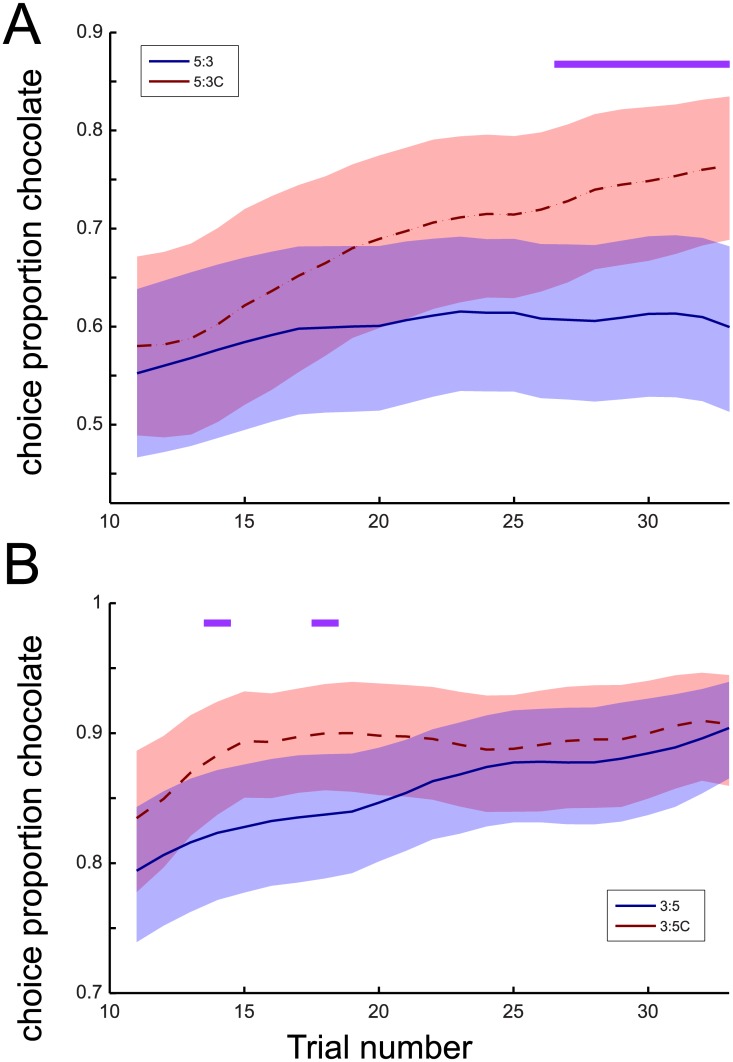
Time-resolved proportion of choice for chocolate as a function of trial number A) Time-resolved proportion of chocolate choice was modelled from trial 11 to 35, integrated over choices in the last 10 preceding trials.Mean choice proportion estimates with bootstrapped 95% confidence intervals for the conditions with expensive chocolate are displayed for the 5:3 (uncompensated, blue line) and 5:3C (compensated, red dashed line) conditions. Purple bar: Difference in Z-value > 1.96 (p<0.05, Bonferroni-corrected for multiple comparisons to |Z|>3.07). B) as in A), but now for choice proportions estimated for the conditions with inexpensive chocolate (3:5, uncompensated, blue line; 3:5C, compensated, red dashed line).